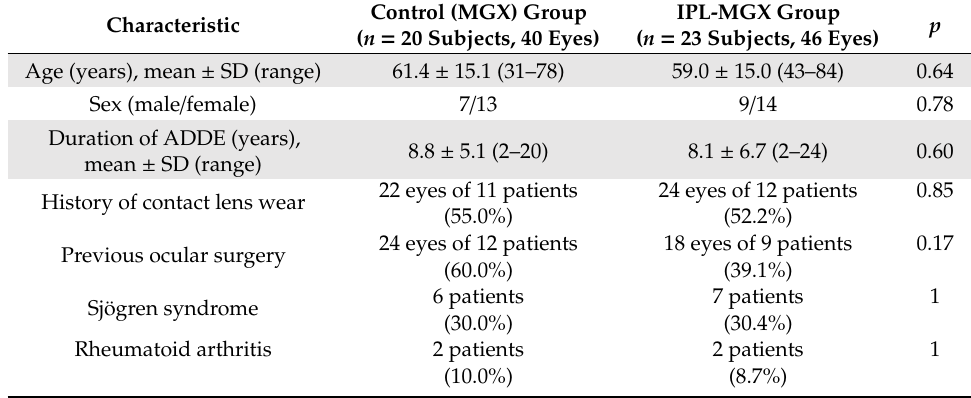
Table 1. Characteristics of the study subjects with aqueous-deficient dry eye (ADDE) and mild meibomian gland dysfunction in the intense pulsed light (IPL)-meibomian gland expression (MGX) and MGX (control)